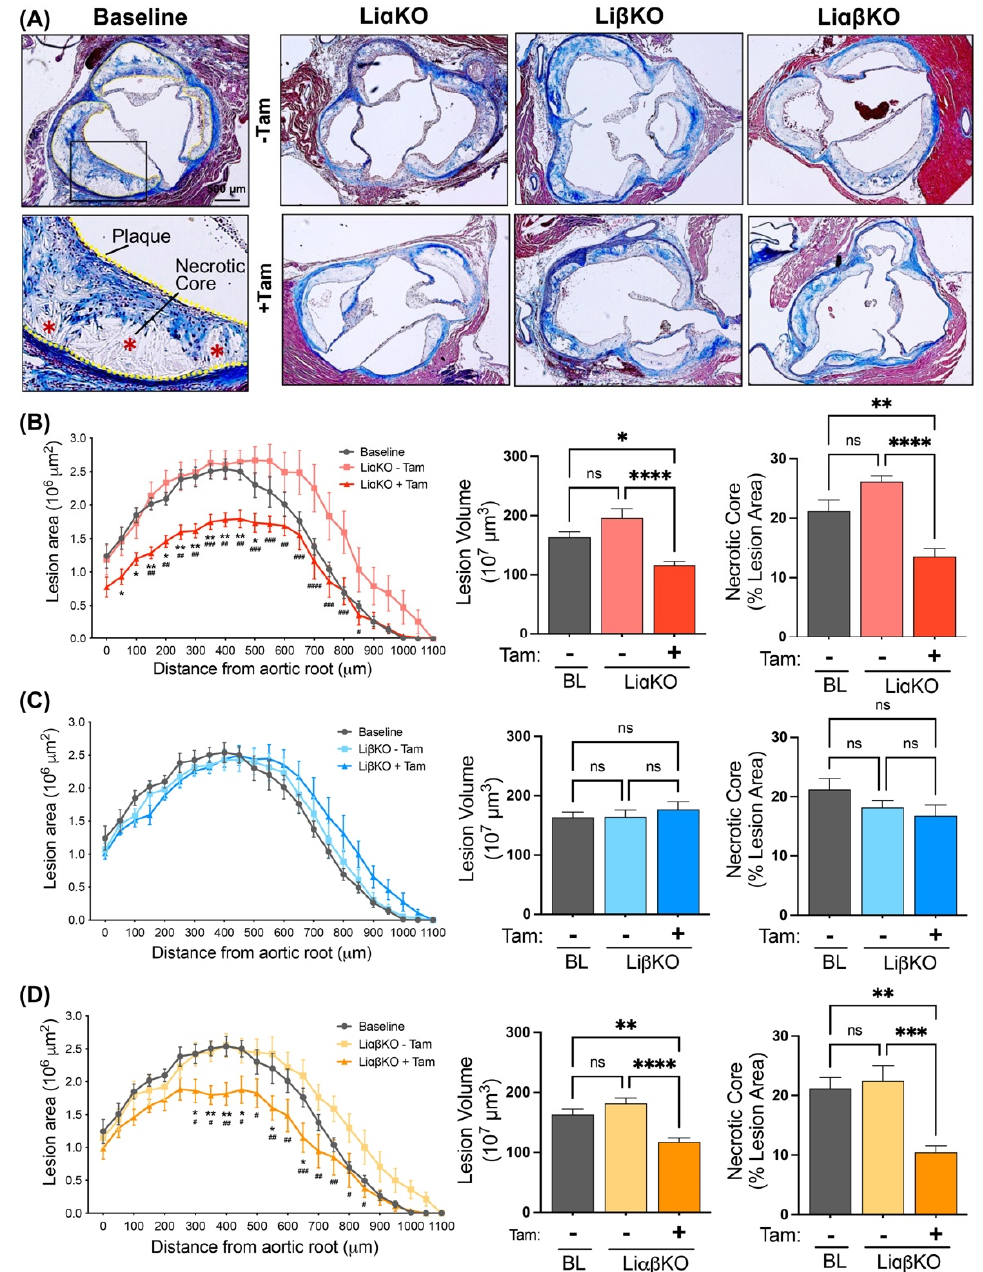
Figure 1. Macrophage-specific GSK3 α -, but not GSK3 β -, deficiency promotes atherosclerosis plaque regression in female Ldlr − / − mice. ( A ) Representative Masson’s trichrome stained aortic root sections from high-fat diet fed baseline, Li α KO, Li β KO, and Li αβ KO mice with and without tamoxifen treat- ment. Quantification of atherosclerotic lesion area, lesion volume, and % necrotic area at the aortic sinus and ascending aorta in ( B ) Li α KO, ( C ) Li β KO, and ( D ) Li αβ KO mice. n = 9–13; mean ± SEM; * represents the comparison to baseline; * p < 0.05, ** p < 0.01, *** p < 0.001, **** p < 0.0001 and # repre- sents the comparison between − Tam and +Tam; # p < 0.05, ## p < 0.01, ### p < 0.001, #### p < 0.0001 (one- way ANOVA). Tam, tamoxifen; BL, baseline. ns, not significant. En face aortas from female baseline, Li α KO, Li β KO, and Li αβ KO mice were stained with Sudan IV to quantify atherosclerotic plaques in total aorta (Figure 2A). Li α KO and Li αβ KO mice treated with tamoxifen had significantly less atherosclerotic lesion area across the entire aorta (aortic arch and thoracic aorta) compared to baseline and the re- spective untreated control groups (Figure 2B–D). Li β KO mice treated with tamoxifen